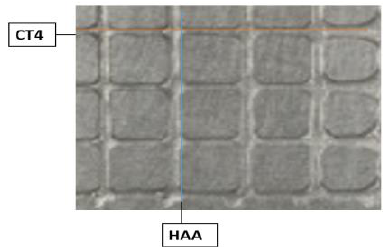
Figure 10. The mesh photo of HAA and CT4.